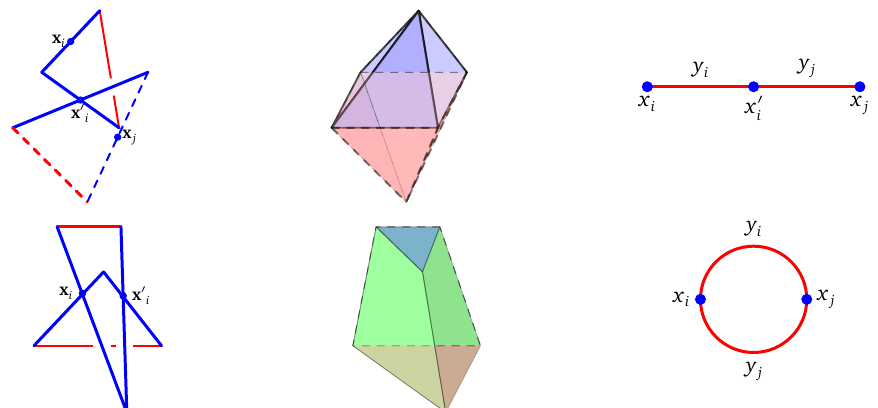
Figure 2: Visualisation of two cosmological polytopes. They are, respectively, ob- tained from the intersection of two triangles (on the left column) in one and two midpoints. The central and the right columns depict the corresponding convex hulls and the associated reduced graphs, respectively [ 34 ]